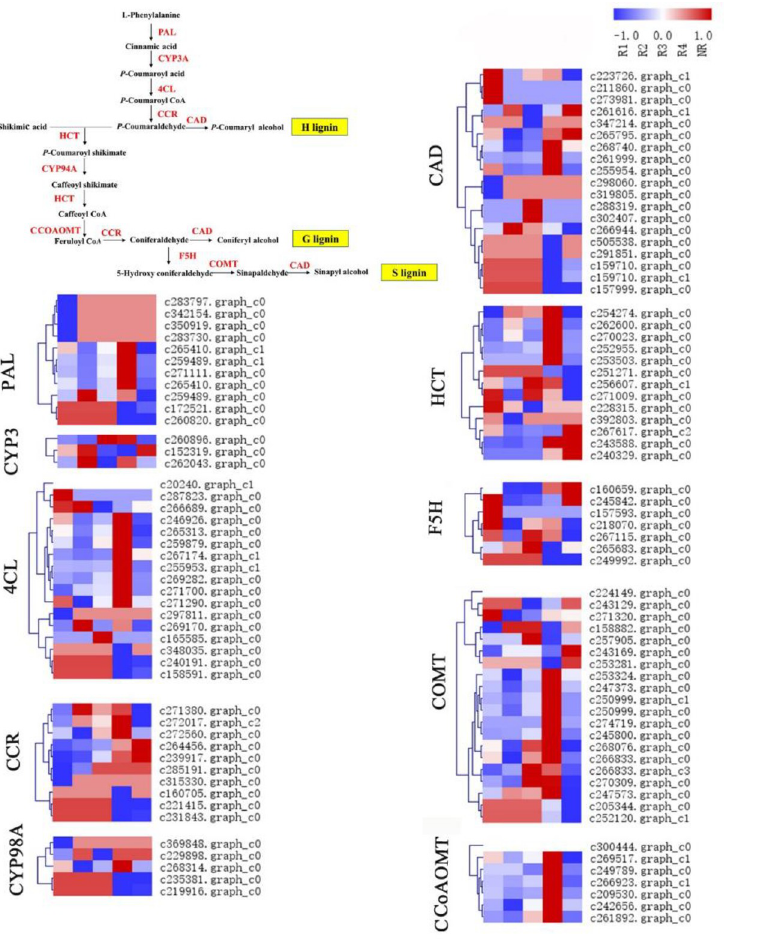
Fig 6. Heat map of phenylpropanoid biosynthesis-related genes in the five tissues.